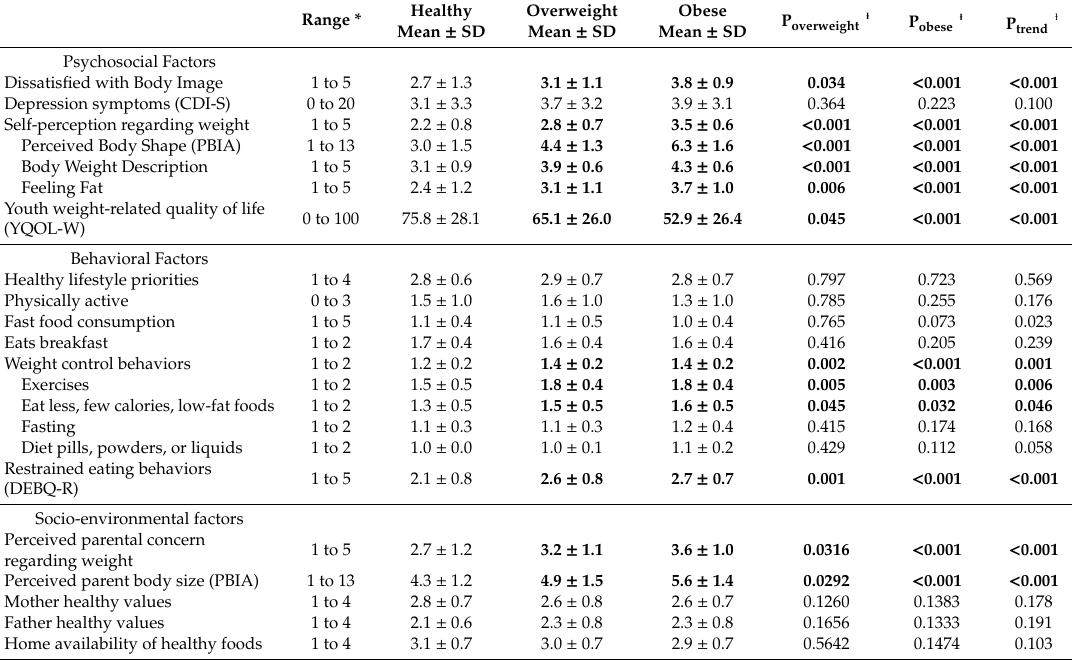
Table 2. Comparison of various psychosocial, behavioral, and socio-environmental factors by BMI category among youths in Mexico ( n = 181). * A higher score indicates a greater frequency or agreement; ¶ Reference category for comparisons between BMI groups; ⱡ Differences between means were performed using t-tests; ƚ Cuzick’s trend test; statistically significant results are in bold.